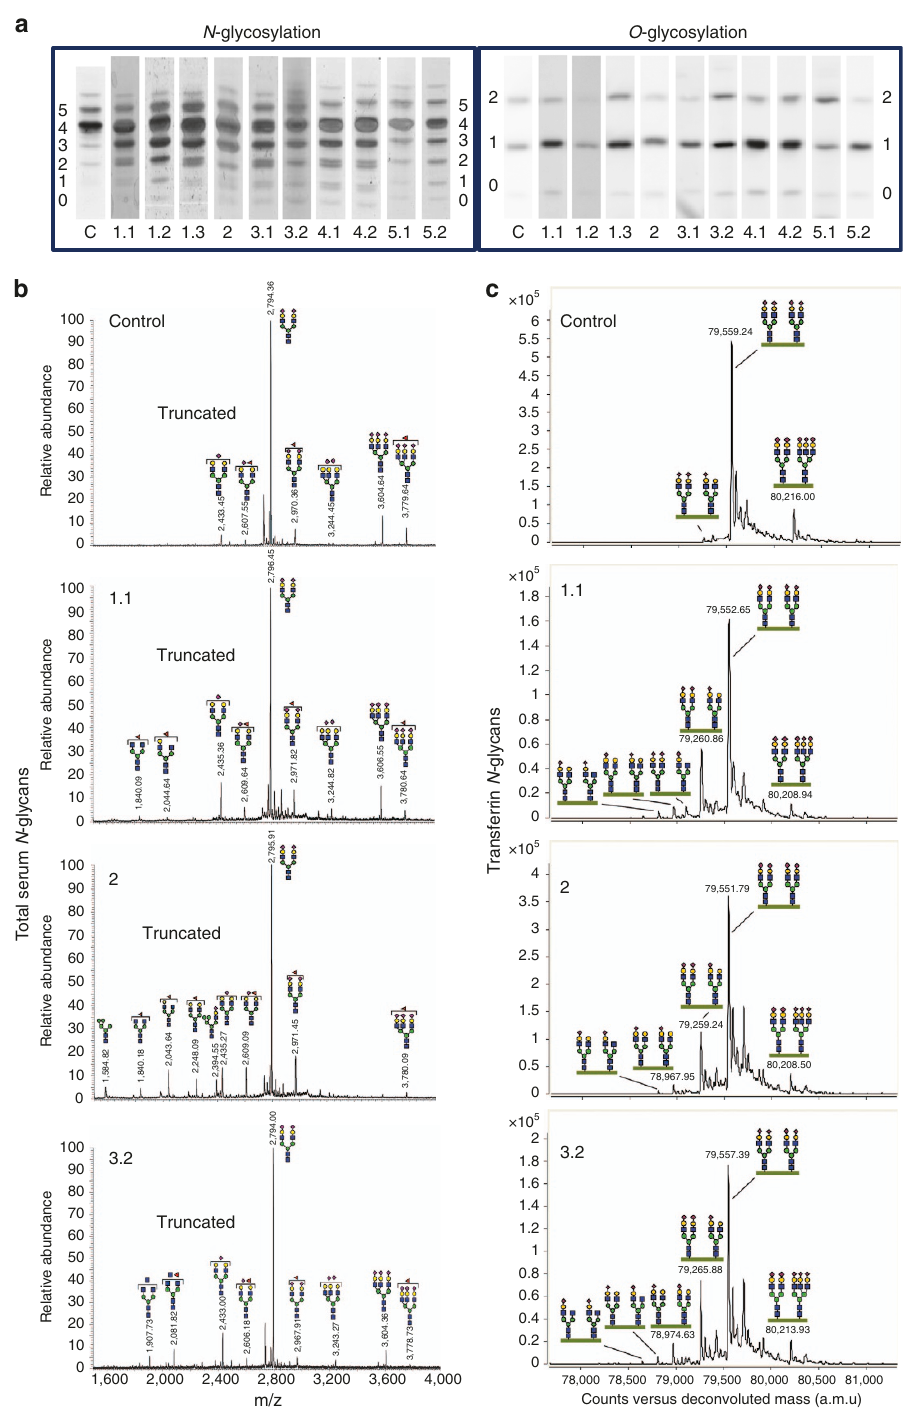
Figure 3 | Glycosylation studies. ( a ) Routine screening for N -glycosylation by isofocusing of serum transferrin and for mucin type O -glycosylation by isofocusing of apolipoprotein CIII. The numbers on the y axis mark the number of sialic acids, each column shows the profile of the respective control (C) or patient. ( b ) Analysis of total serum protein N -glycans by MALDI mass spectrometry. ( c ) Analysis of intact serum transferrin by nanoLC-chip-QTOF mass spectrometry. Glycans are synthesized from individual monosaccharide building blocks: a purple diamond represents one sialic acid, a yellow circle one galactose, a green circle one mannose, a blue square one N -acetylglucosamine and a red triangle one fucose. See also Supplementary Fig. 3 and Supplementary Tables 2 and transformed with empty vector or cells expressing Voa1QQ. protein 12,14,15 , the C-terminal half of Ac45 was expressed. This processed Ac45 was able to function in place of Voa1, but only when expressed with a dilysine motif (cleaved-Ac45-KKNN in Fig. 5c). By complementation, cleaved-Ac45-KKNN function is comparable to that of Voa1.